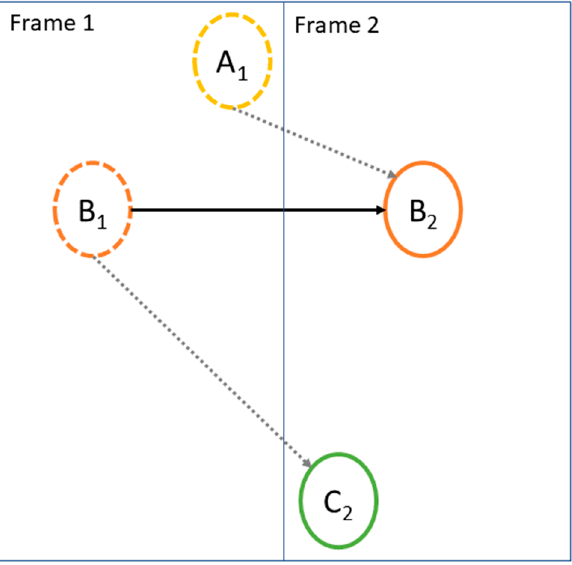
Figure 4. Example of multiple-to-one assignment for three fruit (A, B, C): both A 1 and B 1 are assigned